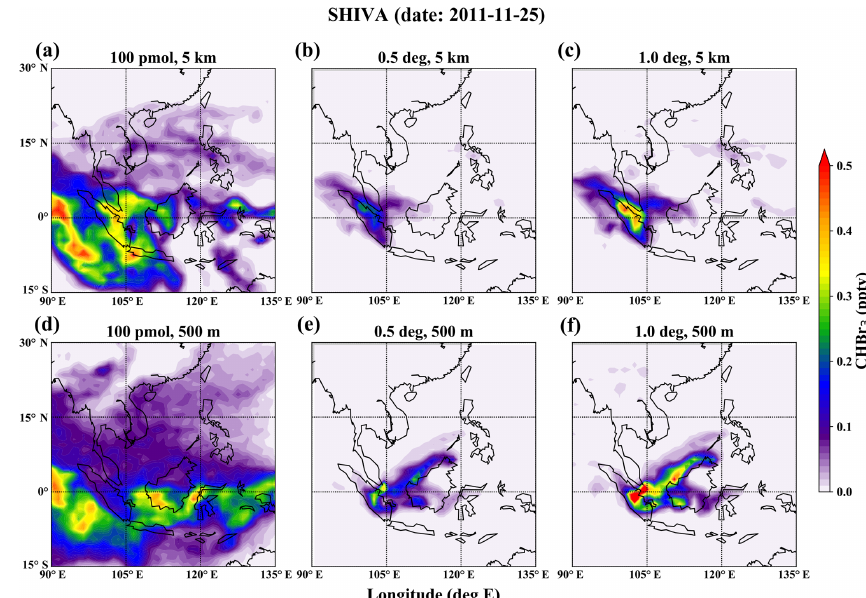
Figure 10. Same as Fig. 9, but for the SHIVA